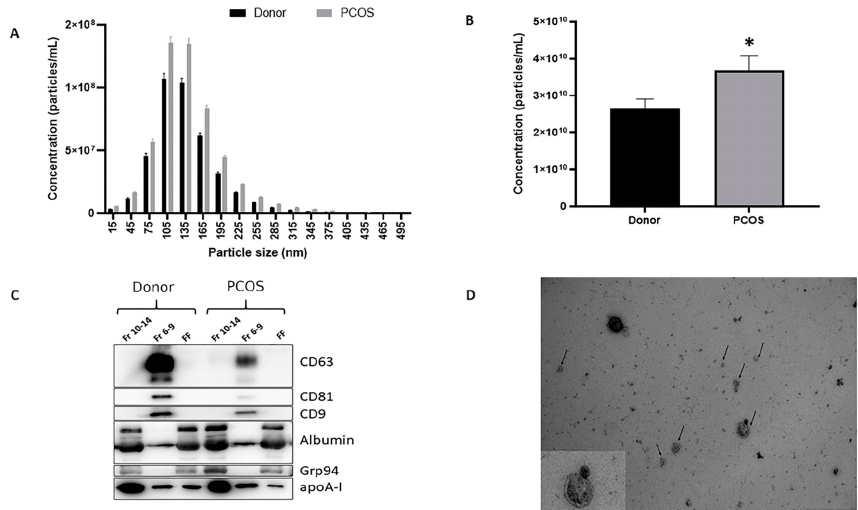
Figure 2. Characterization of extracellular vesicles (EVs) isolated from cell-free follicular fluid (FF). ( A ) Size profile of EVs in study groups (mean ± SEM). ( B ) Concentration of EVs in polycystic ovarian syndrome patients (PCOS) and control samples (mean ± SEM). ( C ) Positive signals of EV markers CD63, CD81, CD9 were detected from EV samples (Fr 6-9), while undetectable from protein fractions (Fr 10-14) and FF samples before EV isolation (FF). Albumin, Grp94, and apoA-I were used as markers of negative selection demonstrating diminished signal intensity in EV samples compared to the protein fraction and FF samples. ( D ) Transmission electron microscopy analysis of purified EVs, indicated by